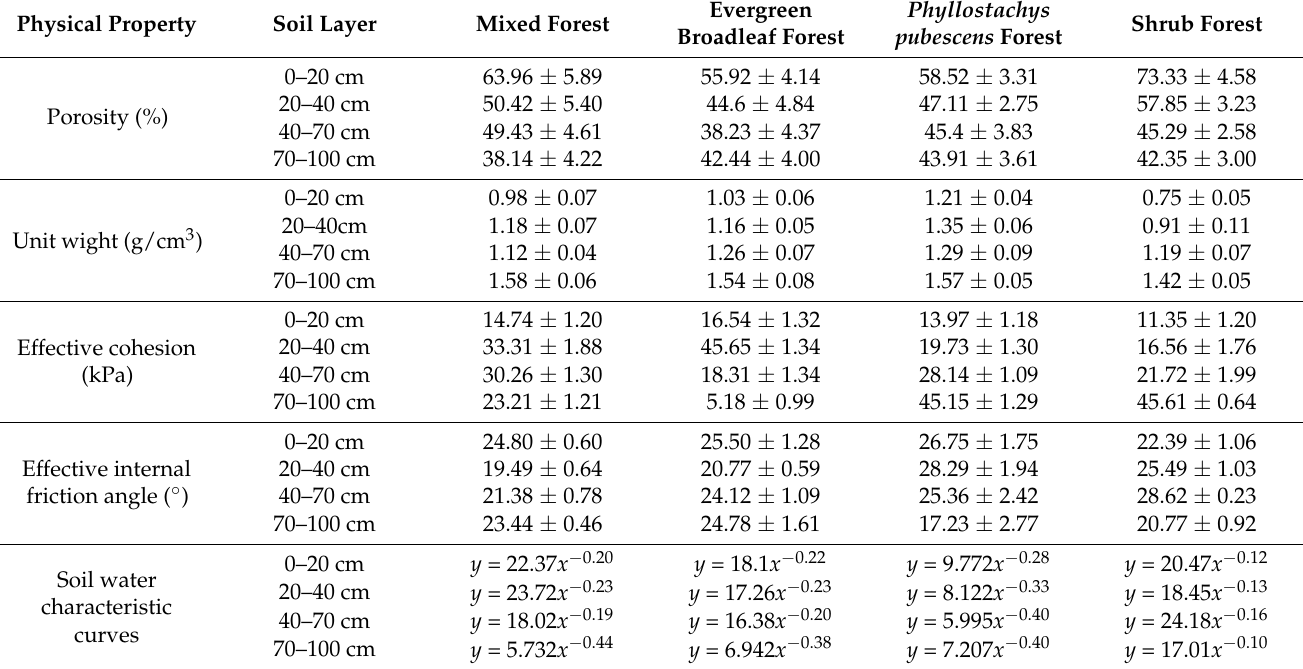
Figure 5. Soil moisture (volumetric moisture) variation rate with rainfall amount in different forestlands. Table 1. Physical properties of soil in different forest lands.